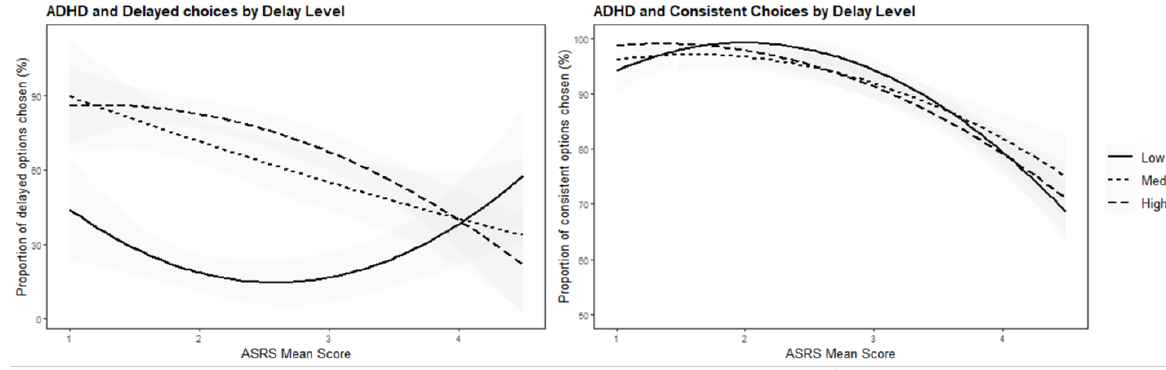
Figure 2. ( a ) Regressions (quadratic term) of the relationship between the level of ADHD symptoms (ASRS mean score) and the proportion of choices to wait for low (solid line), medium (dotted line), and high (dashed line) levels. i.e., low= better immediate and high= better delay ( R ² = 0.11; R ² = 0.31, respectively). ( b ) The main effect of ADHD (quadratic) on the proportion of consistency in the three levels: low (solid line), medium (dotted line), and high (dashed line).